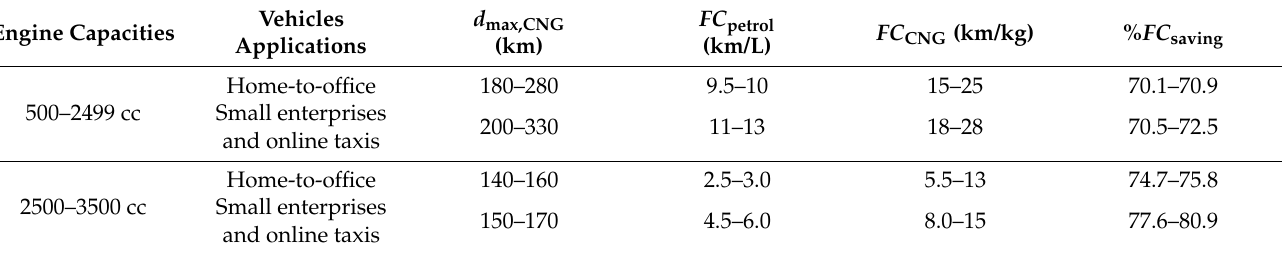
Figure 4. The comparison of consumption and fuel saving for gasoline vehicles with different engine capacities. Table 2. The effect of vehicle applications on fuel saving.